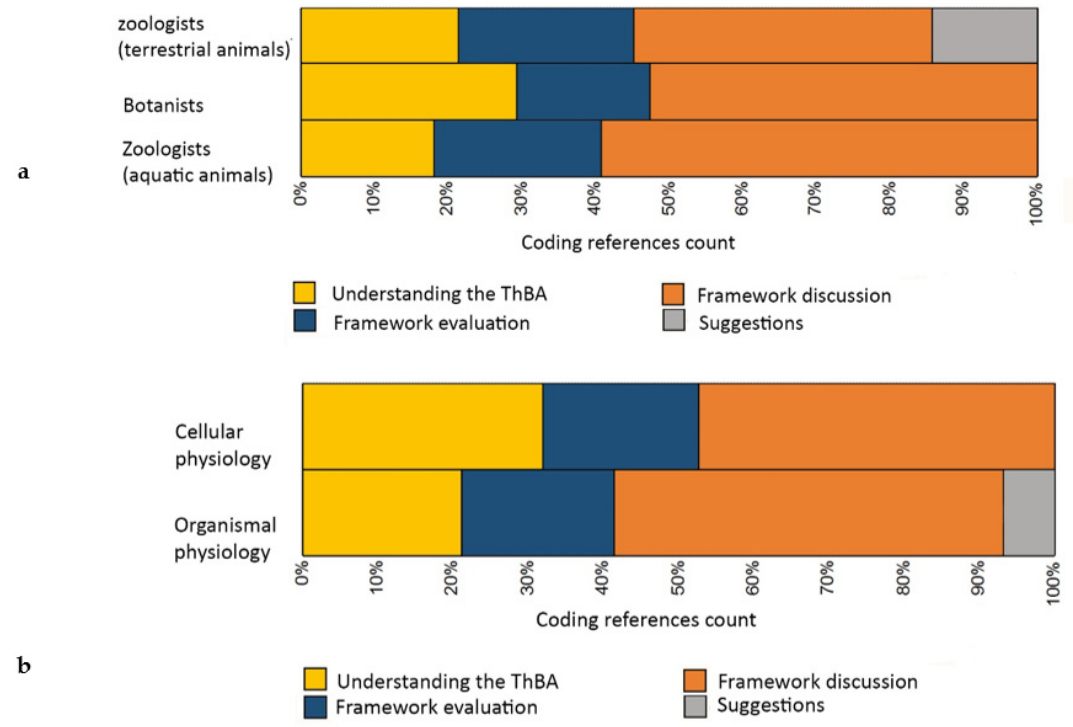
Figure6. Distributionofcontributionsbasedon( a )participantexpertise, ( b Figure 6. Distribution of contributions based on ( a ) participant expertise, ( b ) biological scale under focus.